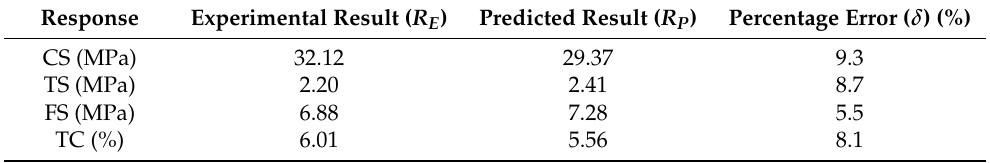
Table 8. Experimental